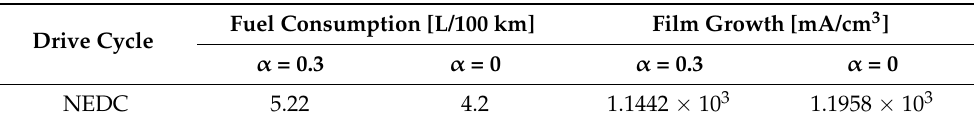
Table 2. Fuel consumption and film growth over the single NEDC cycle.